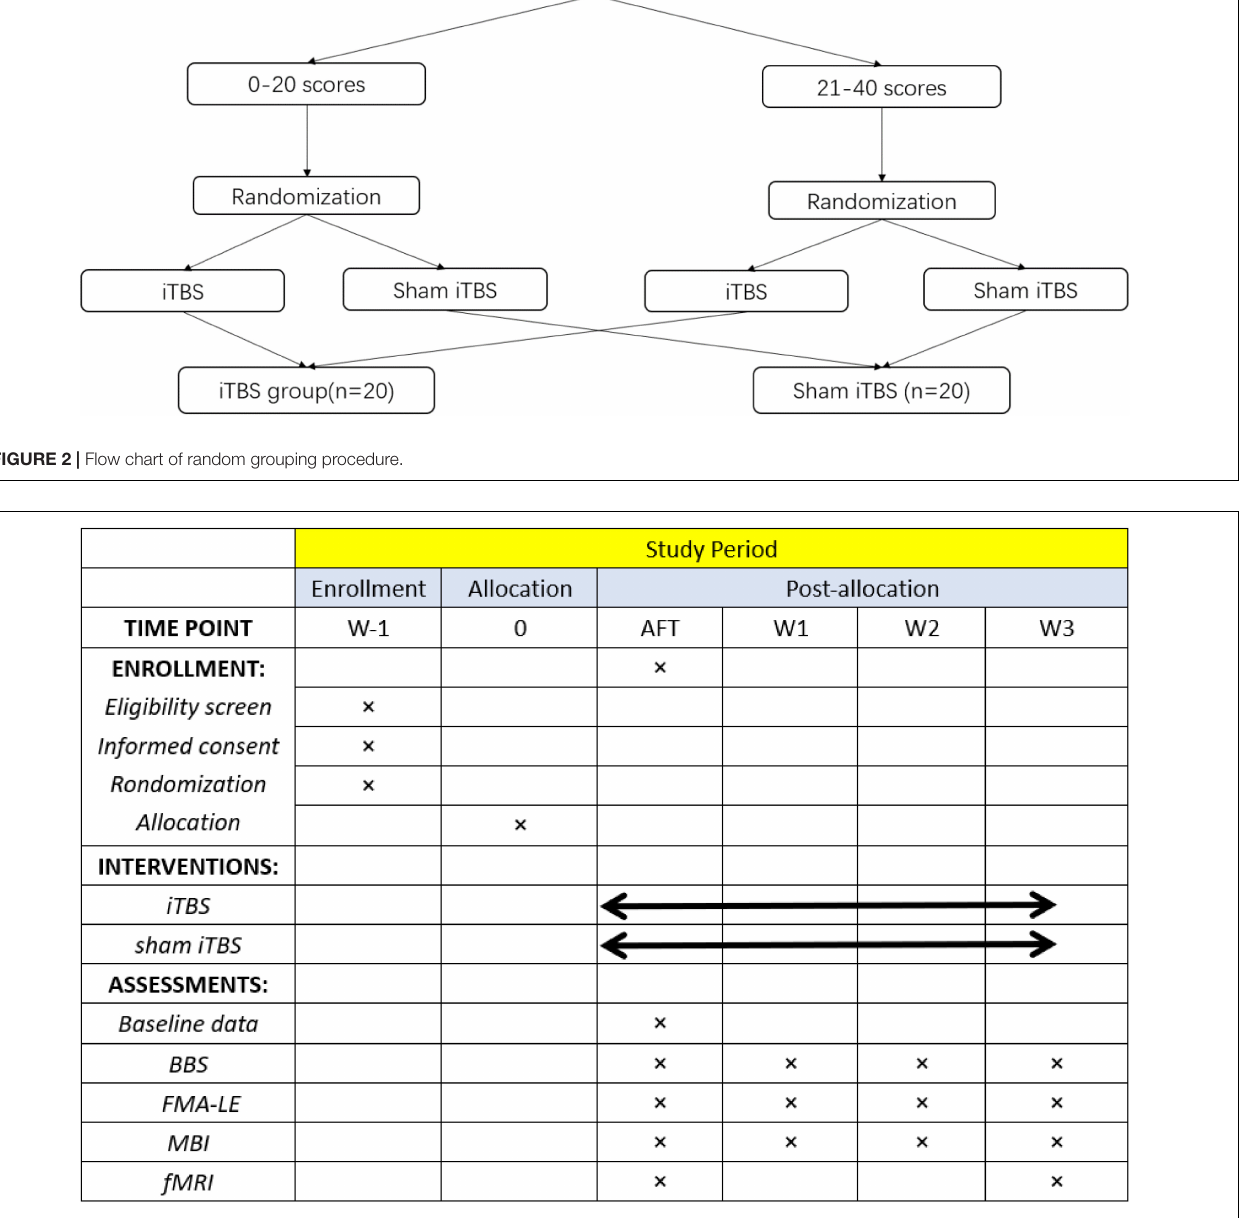
FIGURE 3 | Schedule of participant enrollment, interventions, and assessments. BBS, Berg Balance Scale; FMA-LE, lower extremity of the Fugl–Meyer assessment; MBI, modified Barthel index; fMRI, functional magnetic resonance imaging.